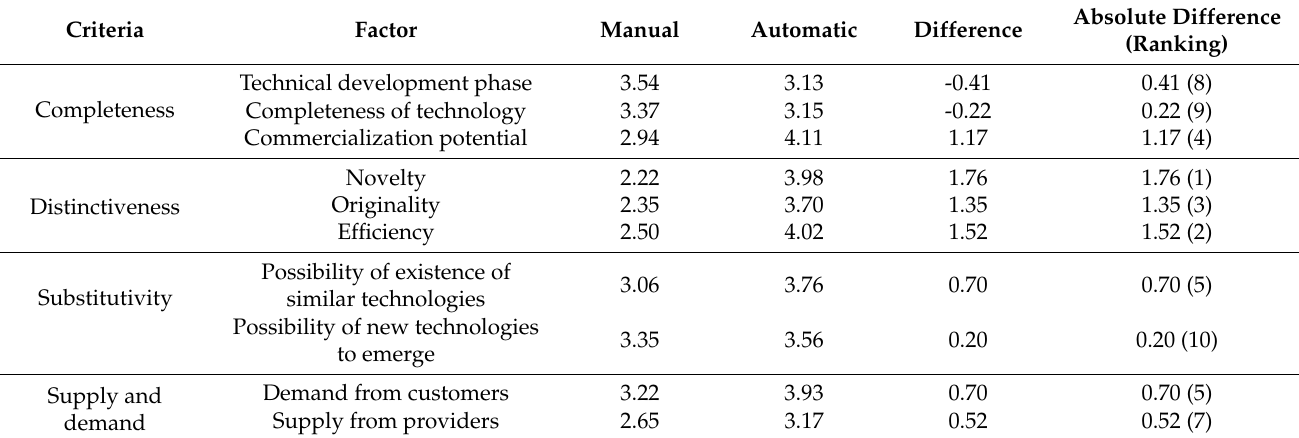
Figure 6. Radar diagram from scores on 5-point scale of both manual and automatic approaches. Table 7. Score result of manual and automatic floor plan analysis